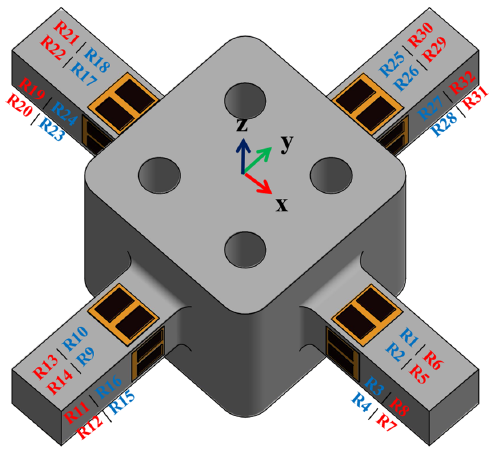
Figure 8. Strain gage placement on the structure.